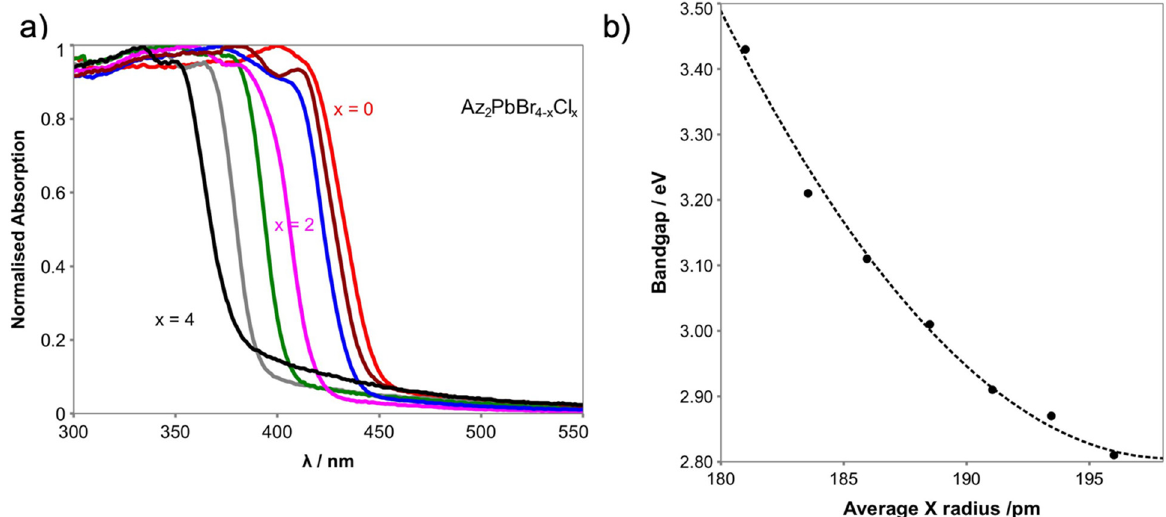
Figure 4. ( a ) Absorption spectra; ( b ) bandgap determination from the absorption spectra of samples Az 2 PbCl x Br 4 − x with composition 0 ≤ x ≤ 4 plotted as a function of average halide anion radius.